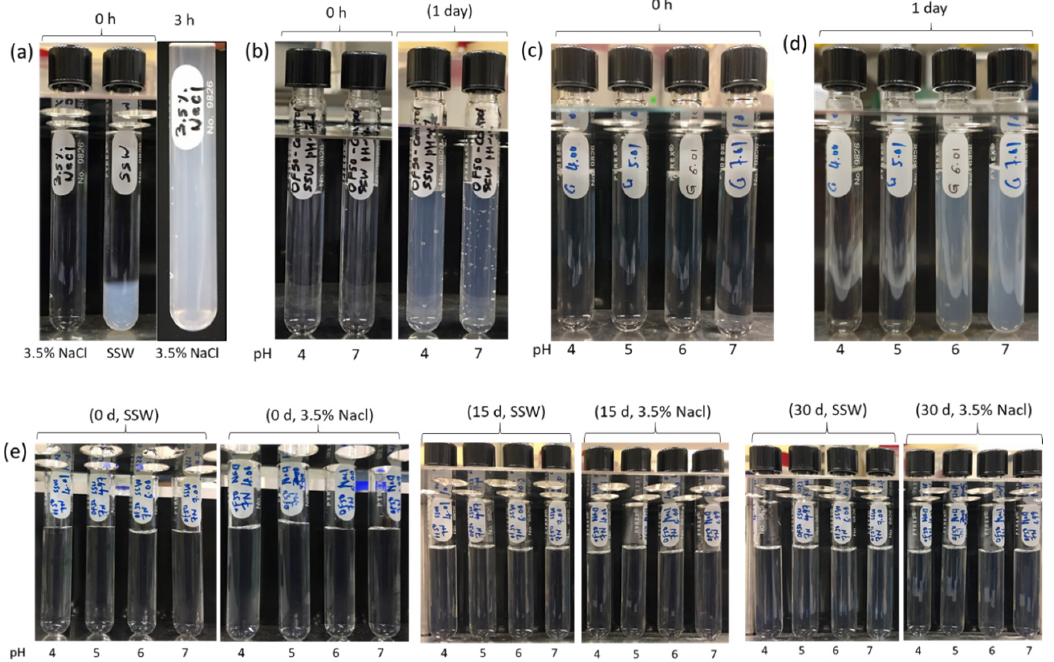
Figure 5. Thermal stability of 1 wt.% ( a ) OF50-UM in synthetic seawater (SSW) and 3.5% NaCl, ( b ) SBS modified particles (OF50-C1) in SSW at pH 4 and 7, ( c ) nanoparticles modified with GLYMO (OF50-C2) in SSW at pH 4–7 at 0 h, ( d ) OF50-C2 in SSW at pH 4–7 after 1 day, and ( e ) OF50-M in SSW and 3.5% NaCl brine at pH 4–7 for 30 days at 60 °C. Results of a real-time turbidity monitoring of 1 wt.% OF50-M in SSW and 3.5% NaCl